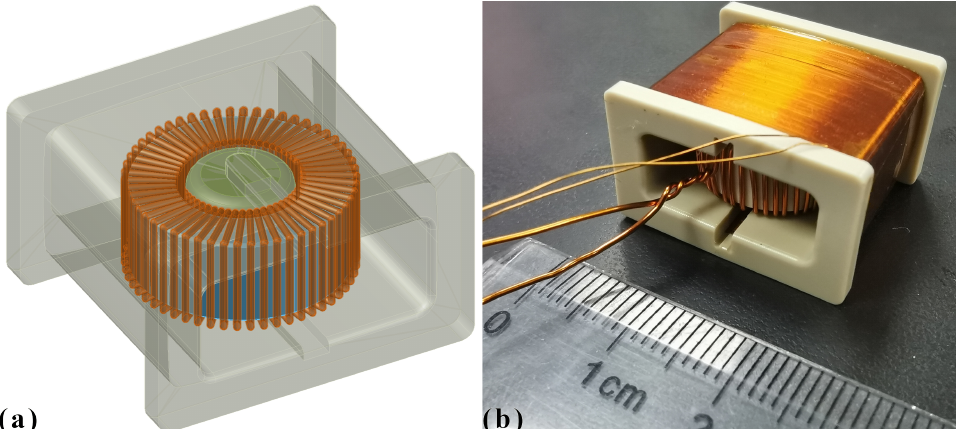
Figure 1. ( a ) A CAD view of the sensor’s core (blue), shaft (green), excitation coil (bronze), coil frame (grey), and how they are assembled. ( b ) A photo of the assembled sensor, with the induction coil wound on the frame and covered with high-temperature polyimide